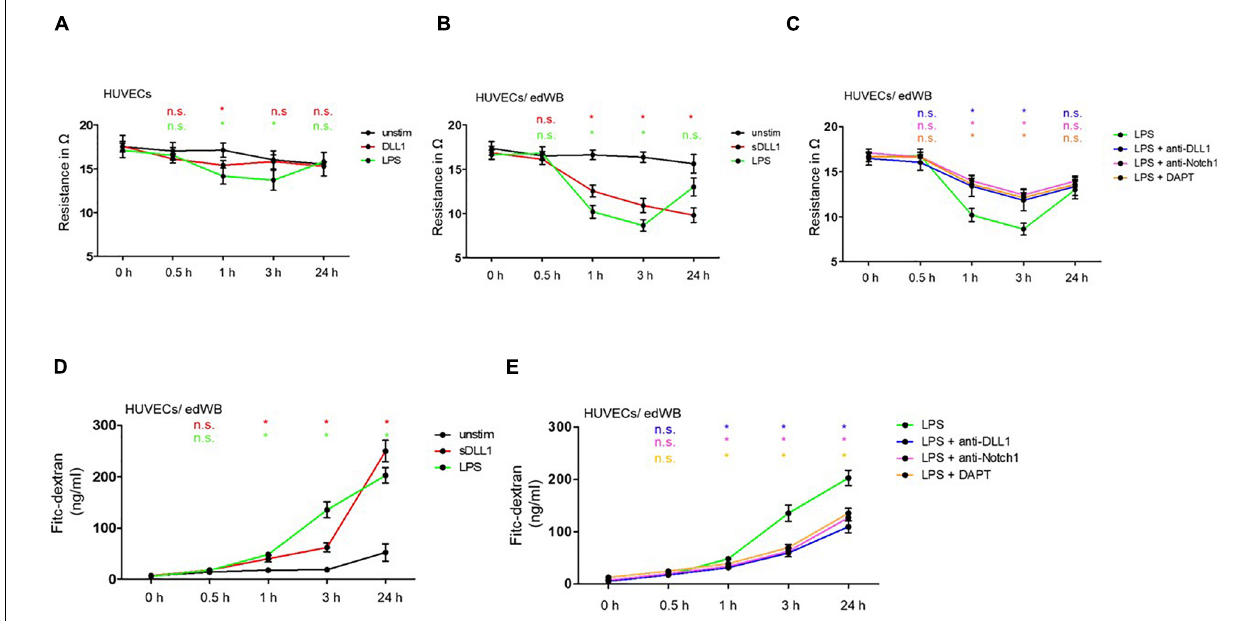
FIGURE 3 | Notch signaling participates in LPS-mediated vE permeability. HUVECs cultivated alone (A) or in coculture with edWB (B,C) were stimulated with 100 ng/ml LPS or 5 µ g/ml sDLL1 (B) , or LPS + anti-DLL1 antibody (5 µ g/ml), anti-Notch antibody (5 µ g/ml), DAPT (1 µ M pretreatment for 1 h) for 24 h (C) . TEER was measured with the EVOM2 volt/ohm-meter after 0, 0.5, 1, 3, and 24 h. (D,E) HUVECs were cocultured with edWB and stimulated with 100 ng/ml LPS or 5 µ g/ml sDLL1 (D) or LPS + anti-DLL1 antibody (5 µ g/ml), LPS + anti-Notch1 antibody (5 µ g/ml), DAPT (1 µ M pretreatment for 1 h). (E) FITC-dextran was added on top of the transwells, and fluorescence was measured via a fluorescence reader after 0, 0.5, 1, 3, and 24 h in aliquots taken from the lower chamber. Data were analyzed using Prism9 and significance was calculated using a one-sided Mann-Whitney U -test. * p ≤ 0.05. Red, significance of sDLL1 vs. unstimulated; green, significance of LPS vs. unstimulated; blue, significance of LPS + anti-DLL1 vs. LPS; pink, significance of LPS + anti-Notch1 vs. LPS; orange, significance of LPS + DAPT vs.